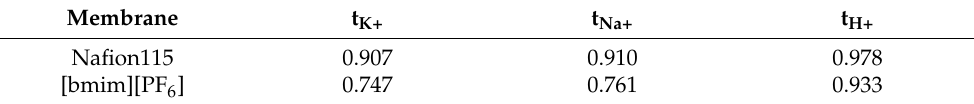
Table 3. Transport numbers of various ions in the cases of Nafion and [bmim][PF 6 ]-SILM. Membrane